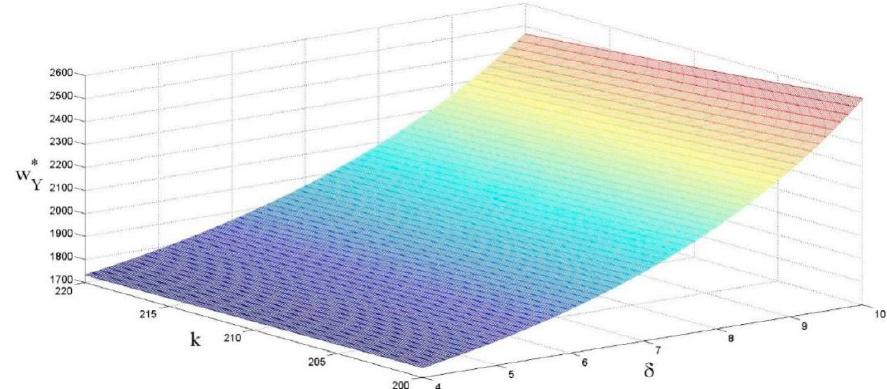
Figure 4. The effects of k and δ on the price of raw materials. Figure 4 . The effects of k and Figure 4 . The effects of k and